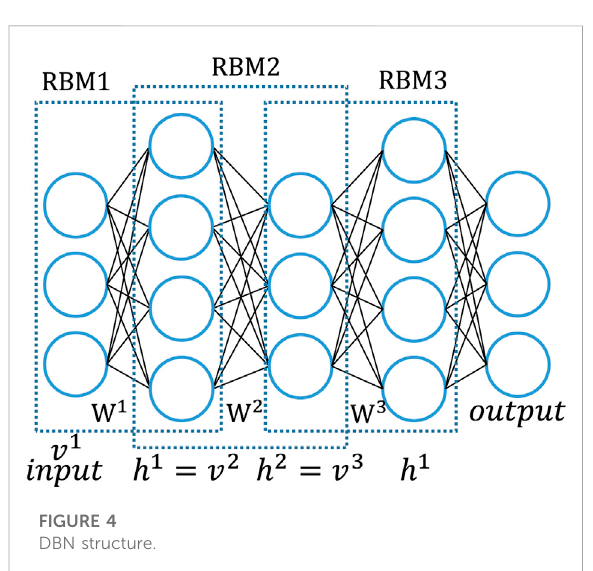
PSO – DBN network